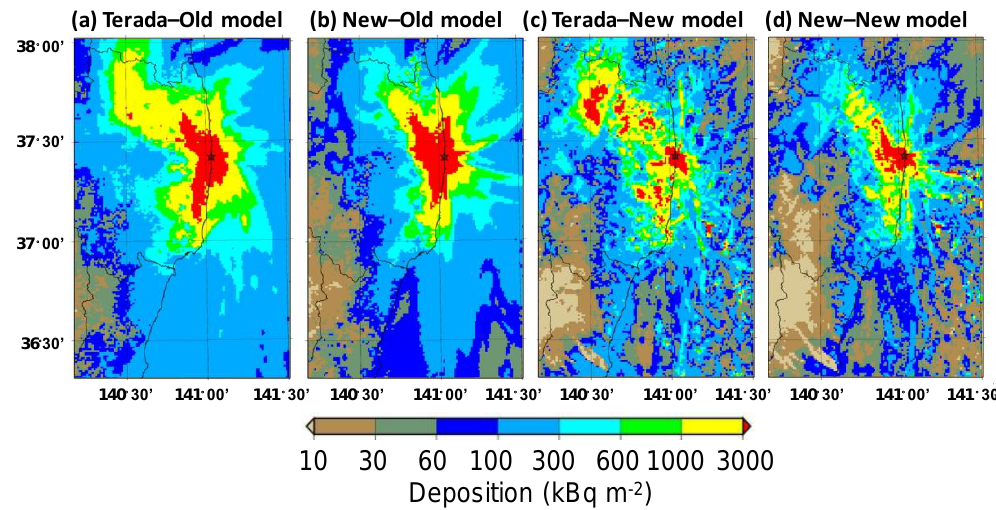
Figure 15. Local-scale spatial distributions of surface deposition of 131 I (Domain 3) in the four simulations using original and modified WSPEEDI-II (referred as “Old model” and “New model”, respectively) and Terada at al. (2012) and the new source terms (referred as “Terada” and “New”, respectively) at 00:00 on 1 April